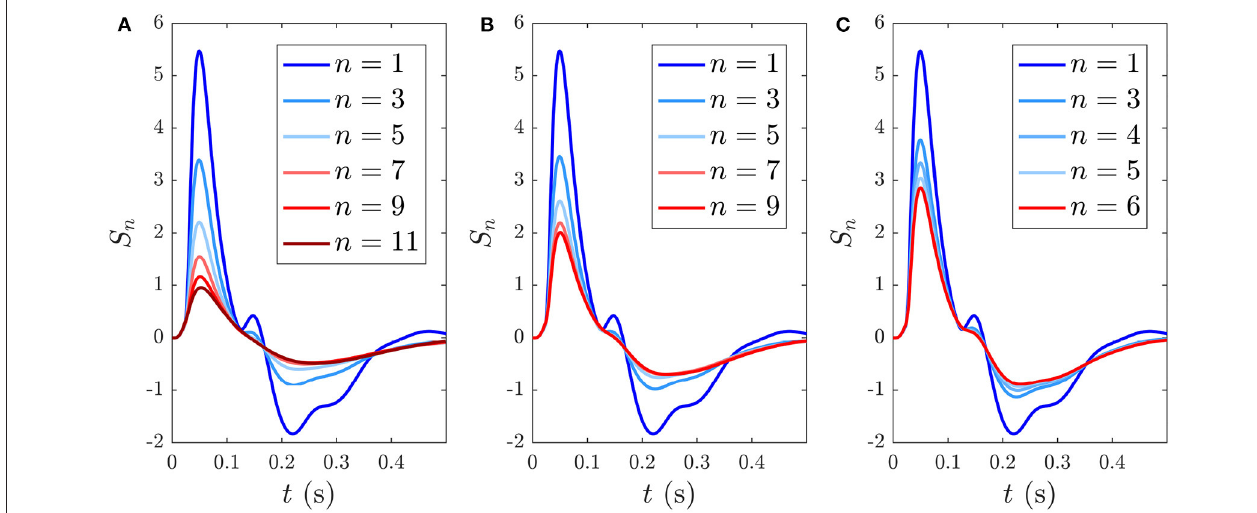
FIGURE 11 | Development of the S n 1, ... ,11 with a 0.5 s ISI. (B) S n ( t ) for n =